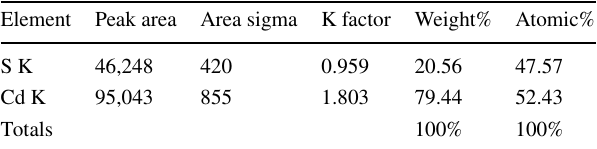
Table 2 Elemental composition analysis of prepared CdS nanoparti-